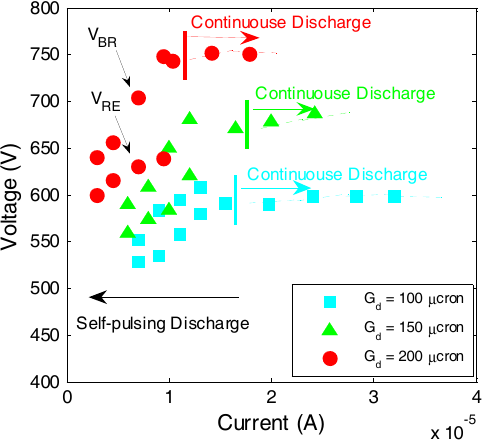
Figure 3. Current and voltage characteristics for micro plasma jet with variation of gap distance. For self-pulsing discharge, both the breakdown voltage ( V BR ) and recovery (sustain) voltage ( V RE ) are